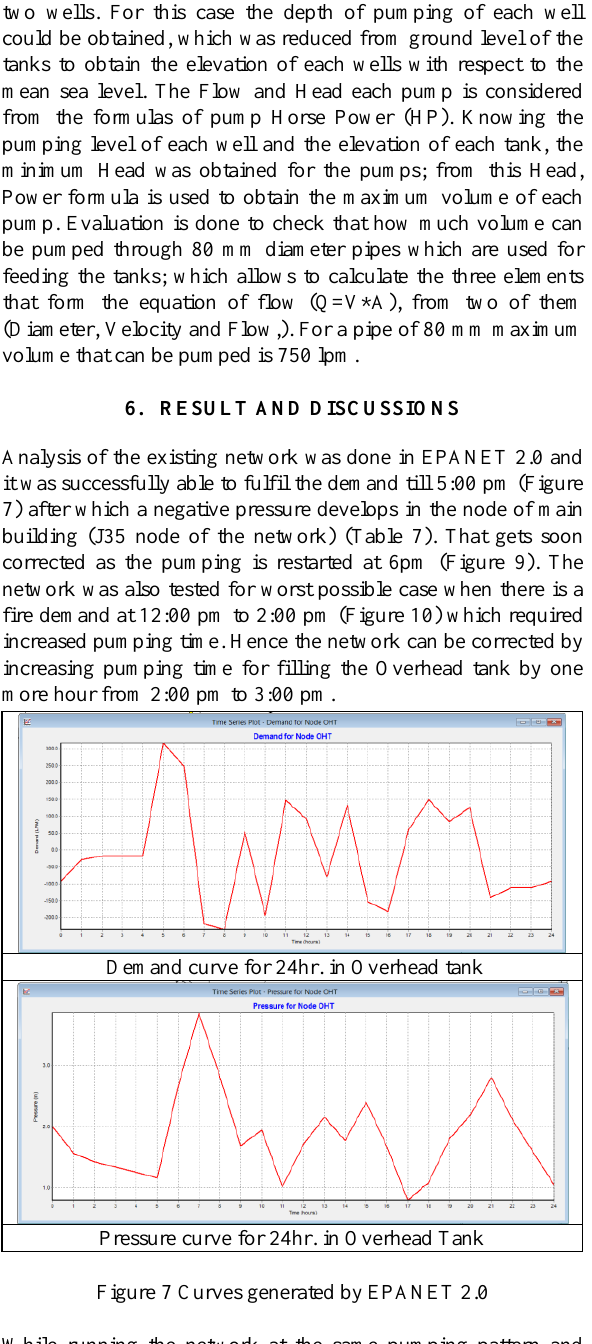
Figure 8 Pressure curve of overhead tank of unsuccessful